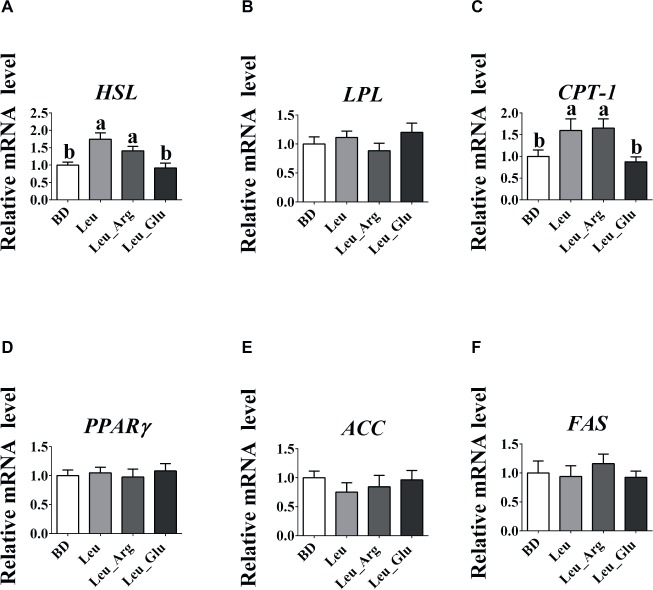
The mRNA expression levels of fat-metabolism genes in the subcutaneous adipose tissues. The relative mRNA expression levels of HSL (A), LPL (B), CPT-1 (C), PPARγ (D), ACC (E), and FAS (F). Data represent the means ± SEM. a–cindicate statistically significant differences (p < 0.05).